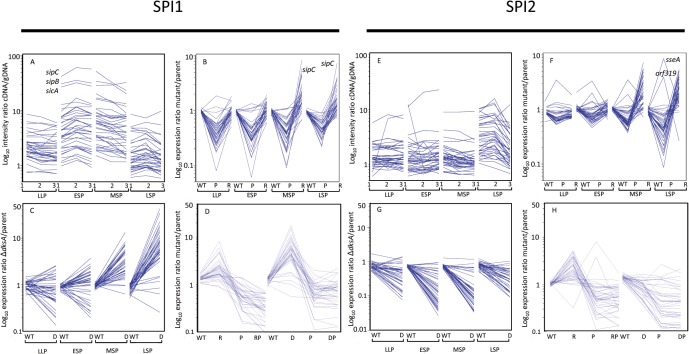
Effect of loss of ppGpp, Rpos and/or DksA on SPI1 and SPI2 expression at late-log phase (LLP), early stationary phase (ESP), mid-stationary phase (MSP) and late stationary phase (LSP).(A, E) SPI1 and SPI2 transcript levels in parent strain (SL1344); 1, 2, and 3 indicate biological replicate cultures. (B, F) SPI1 and SPI2 transcript levels in ΔrelAΔspoT (P) and ΔrpoS (R) strains; transcript levels are normalised to parental (WT) SPI1 transcript levels. (C, G) SPI1 and SPI2 transcript levels in a ΔdksA (D) strain normalised to parent (WT) strain. (D, H) Late stationary phase SPI1 and SPI2 transcript levels in ΔrelAΔspoT (P), ΔrpoS (R), and ΔrelAΔspoTΔrpoS (RP) and ΔrelAΔspoTΔdksA (DP) strains normalised to transcript levels in the SL1344 parent strain. Data from which the figure was compiled and statistical analysis is shown in S2 Fig and also deposited at Gene Expression Omnibus (GEO), superseries accession number GSE63715.